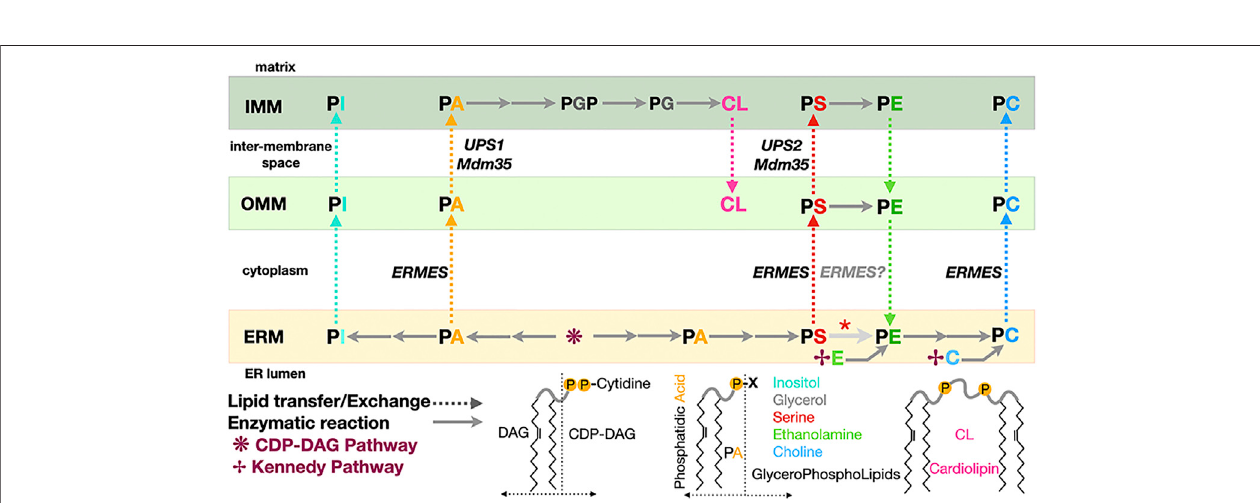
FIGURE 2 | Phospholipid biosynthesis is shared between the endoplasmic reticulum and the mitochondrion. Simpli fi ed pathway for the biosynthesis of the major classes of glycerophospholipids in yeast. PA, phosphatidic acid; PE, phosphatidyl ethanolamine; PS, phosphatidyl serine; PC, phosphatidyl choline; PG, phosphatidyl glycerol; PGP, phosphatidyl glycerol phosphate; PI, phosphatidyl inositol; CL, cardiolipin. CDP-DAG, CDP diacylglycerol. DAG and its “ activated ” form CDP-DAG are some of the main building blocks providing the lipidic backbone of the PLs subsequently synthetized. Two pathways contribute of PL biosynthesis in yeast: the CDP-DAGpathwaytogeneratePAandthenPSsubsequentlytransformedintoPEthenPCandtheKennedypathwayusingDAGandethanolamineorcholinetodirectly generate PE or PC. Dotted arrows indicate PL transfer between membranes within the mitochondrion or between ER and mitochondrion; continuous arrows indicate biosynthetic reactions. A red asterisk indicates that depending on the carbon source, decarboxylation of PS into PE can be observed in the ER membrane. Some of the lipid exchange proteins or membrane tethering complexes (i.e., Ups1/Mdm35 and ERMES) shown to be involved in speci fi c transfer/exchange are indicated.